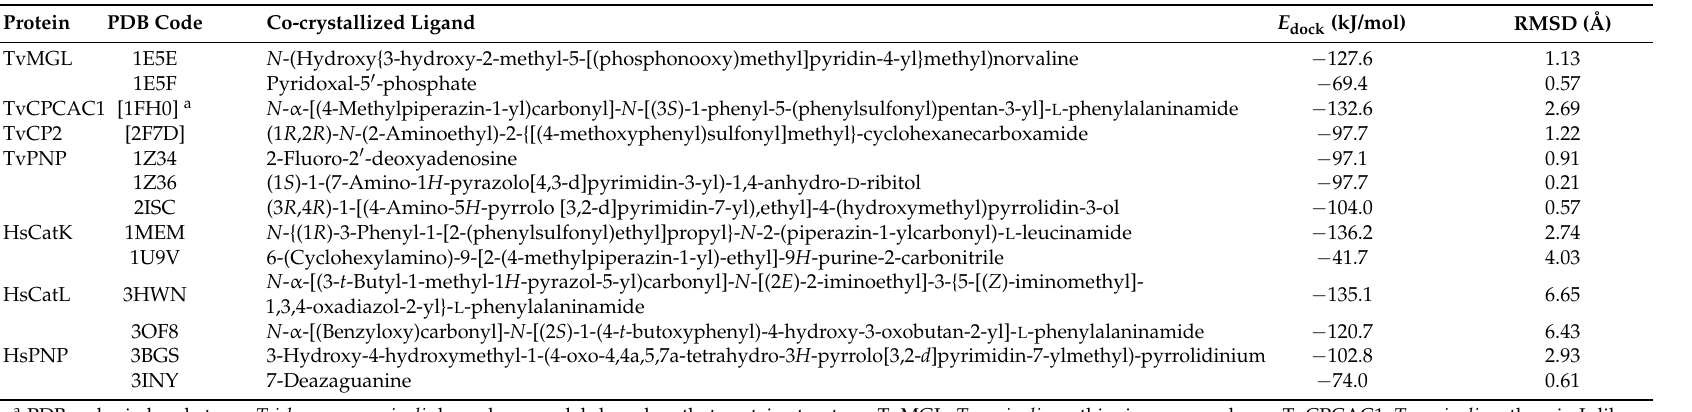
a PDB codes in brackets are Trichomonas vaginalis homology models based on that protein structure. TvMGL, T. vaginalis methionine gamma-lyase; TvCPCAC1, T. vaginalis cathepsin L-like protease; TvCP2, T. vaginalis papain-like cysteine protease C2; TvPNP, T. vaginalis purine nucleoside phosphorylase; HsCatK, human cathepsin K; HsCatL, human cathepsin L; HsPNP, human purine nucleoside